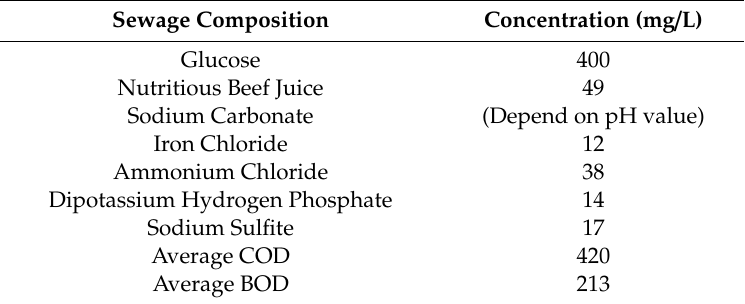
Table 1. Composition of synthetic domestic sewage.